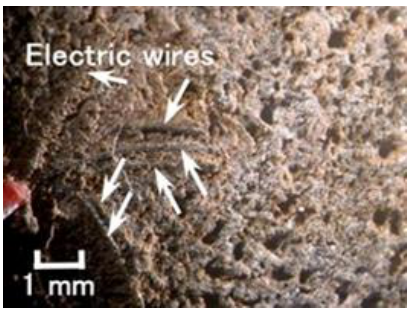
Figure 8. Image of electrical wires adhered to MCF rubber with hydrate inner MCF rubber sensor.